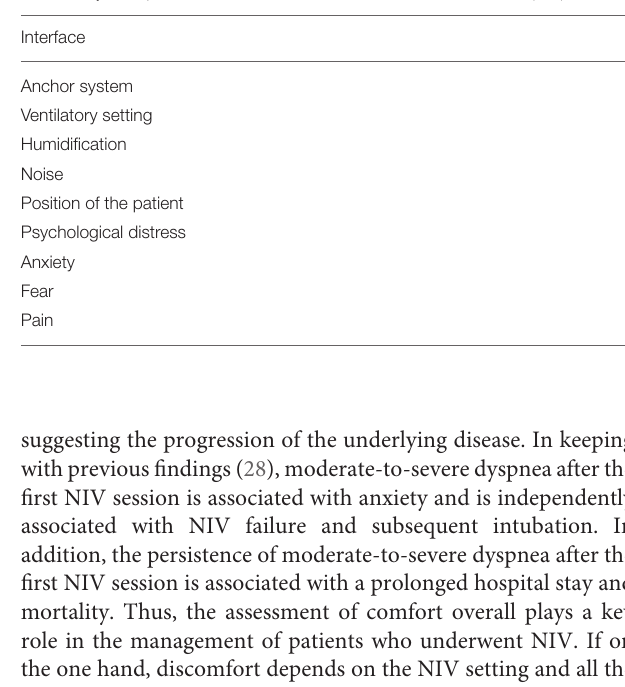
TABLE 1 | Principal causes of discomfort in non-invasive ventilation